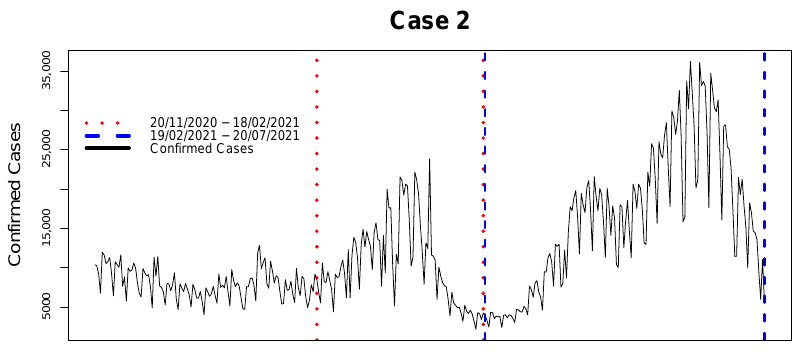
Figure 2. Case 1: Two waves of contagion by COVID-19 in Colombia without a national strike. The dotted red lines mark the start and end of the first wave of contagion, which occurred between 20 November 2020 and 18 February 2021. The dashed blue lines mark the start and end of the second wave of contagion, which occurred between 19 February 2021 and 20 May 2021.